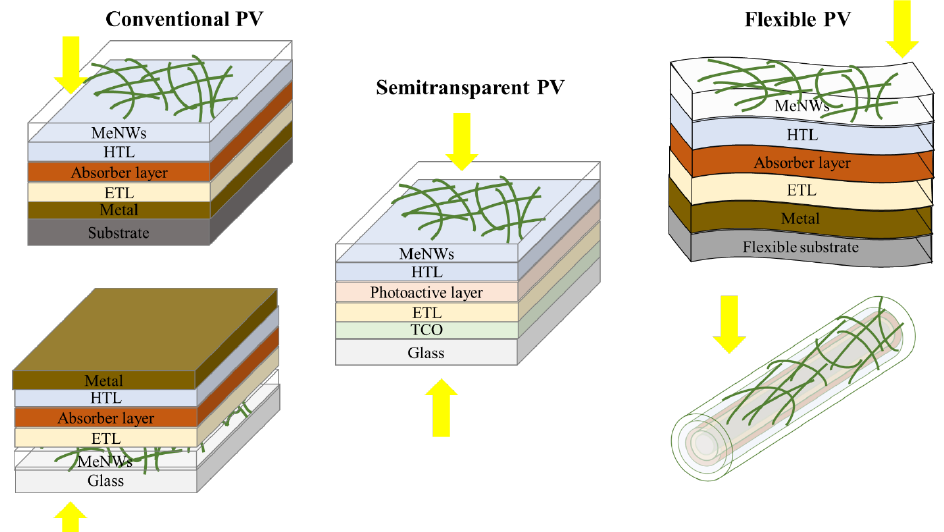
Figure 8. Schematic illustration of the representative solar cell architectures employing metal nanowire networks as the transparent electrode. They are conventional solar cells with a regu- lar stacking architecture and inverted architecture, flexible solar cells with a planar architecture and fibre-shaped architecture and semitransparent solar